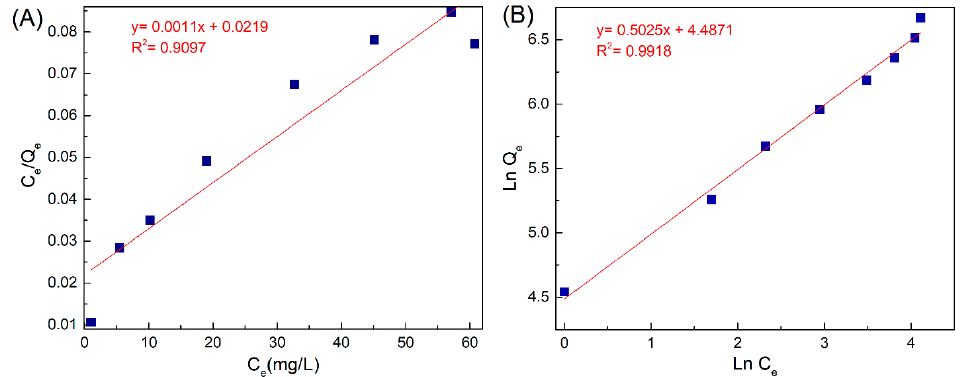
Figure 7. ( A ) Langmuir and ( B ) Freundlich isotherms (condition: amoxicillin concentration (50–400